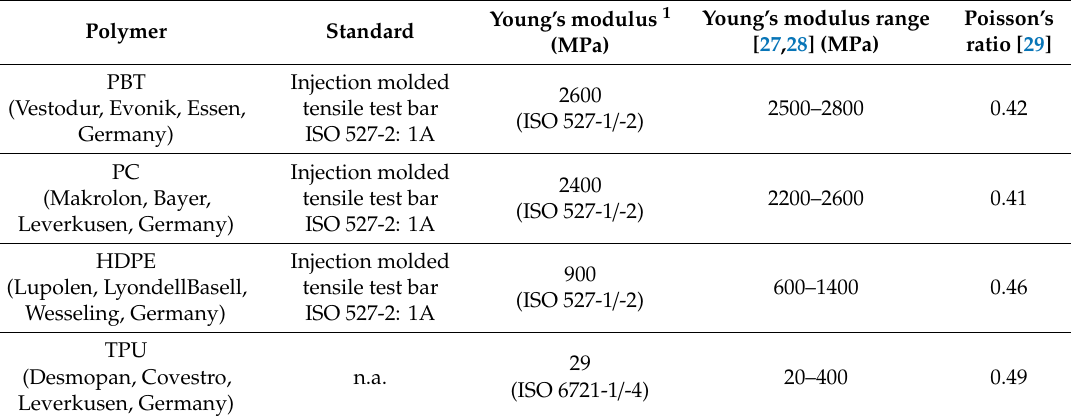
Table 1. Investigated polymers.